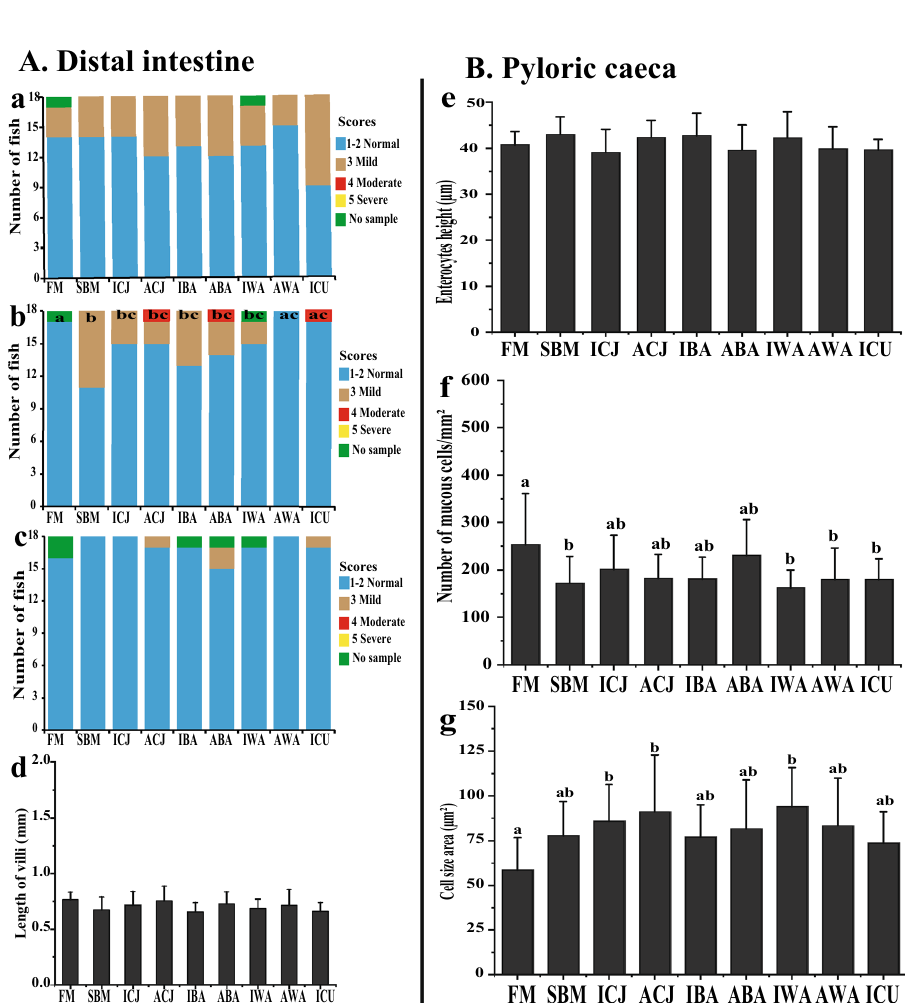
Figure 1. Morphological and histopathological changes in the distal intestine ( A ) and pyloric caeca ( B ) of Atlantic salmon fry fed FM-based diet or SBM-based diets with yeasts. The histological scores were obtained through a semi-quantitative scoring system measuring changes in three morphological parameters: ( a ) loss of supranuclear vacuoles in absorptive enterocytes; ( b ) widening of the lamina propria in mucosal folds; ( c ) increase of connective tissue between base of folds and stratum compactum; and measurement of villi length ( d ). Each parameter ( a – c ) was given a score of “ 1 – 2 ” representing normal morphology; “ 3 – 4 ” mild and moderate enteritis; whereas “ 5 ” denotes severe enteritis. For changes in pyloric caeca, the enterocyte height ( e ), the number of mucous cells/mm 2 mucosal area ( f ) and average mucous cell size ( g ) in the mucosal area are presented. Groups with different letters ( a – c ) above the bar charts are significantly different ( P < 0.05 ). The green bar represents the number of missing fish samples. The diets are: FM -fishmeal-based; SBM -Soybean meal-based; 7 other diets containing 40% SBM and 5% of inactivated Cyberlindnera jadinii ( ICJ ), autolyzed C. jadinii ( ACJ ), inactivated Blastobotrys adeninivorans ( IBA ), autolyzed B. adeninivorans ( ABA ), inactivated Wickerhamomyces anomalus ( IWA ), autolyzed W. anomalus ( AWA ) and ref- C. jadinii ( ICU